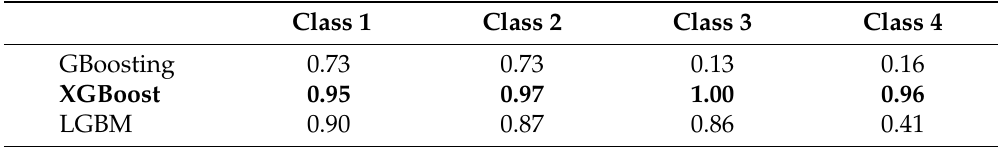
Table 6. Comparison of regressors algorithms using ( R 2 ) as the evaluation metric. This table shows that the XGBoost algorithm is the one that best predicts the number of copies of books for each of the segmentations obtained with the expert’s